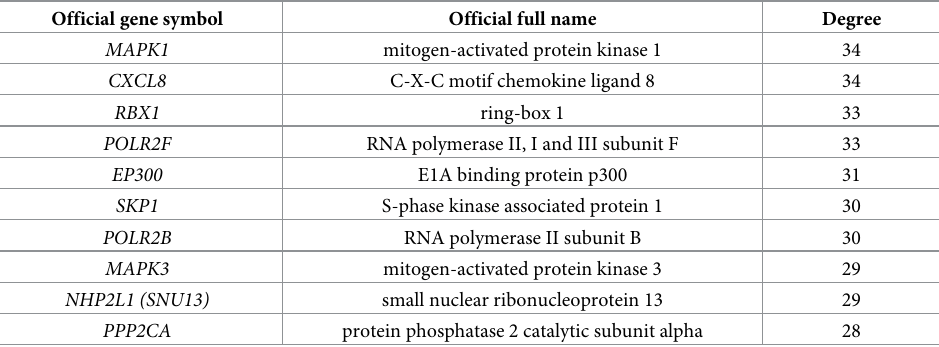
Table 5. The top 10 nodes based on their